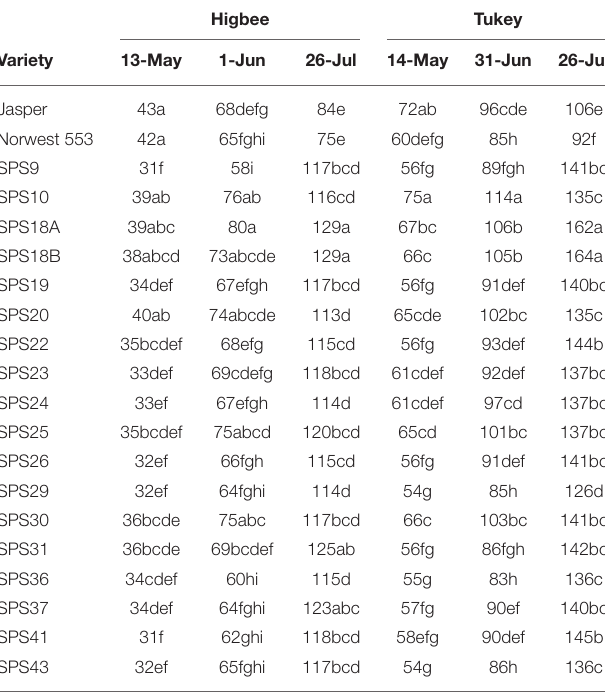
TABLE 2 | Plant height (cm) for annual wheat (Jasper and Norwest 553) and amphiploid lines on different dates at the Higbee and Tukey